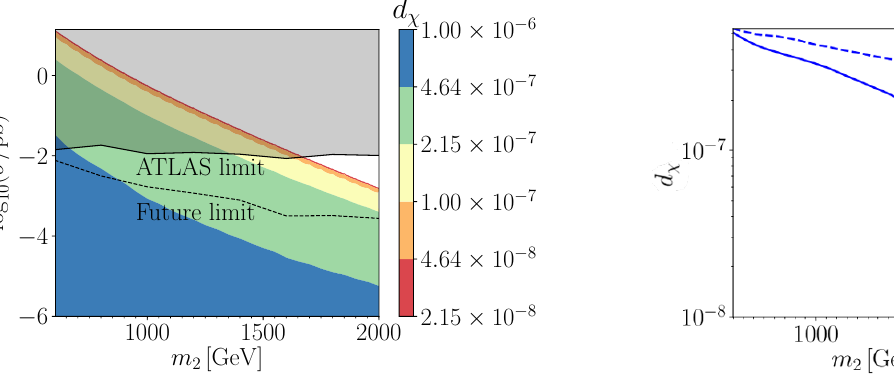
Figure 4 . Left: contours showing the value of the coupling d (cid:31) yielding a given production cross- section for calorimeter-stable (cid:31) 2 , overlayed with the region currently excluded by ATLAS and a high-luminosity projection of exclusions. Right: lower limit on d (cid:31) from current (solid) and projected high-luminosity (dashed) R -hadron constraints as a function of the (cid:31) 2 mass. Smaller values of d (cid:31) will increase the (cid:31) 2 decay length, exceeding the limit on the production cross-section of calorimeter- stable (cid:31) 2 . Note that m 2 is related to the DM mass by the values of (cid:1) m given in (cid:12)gure